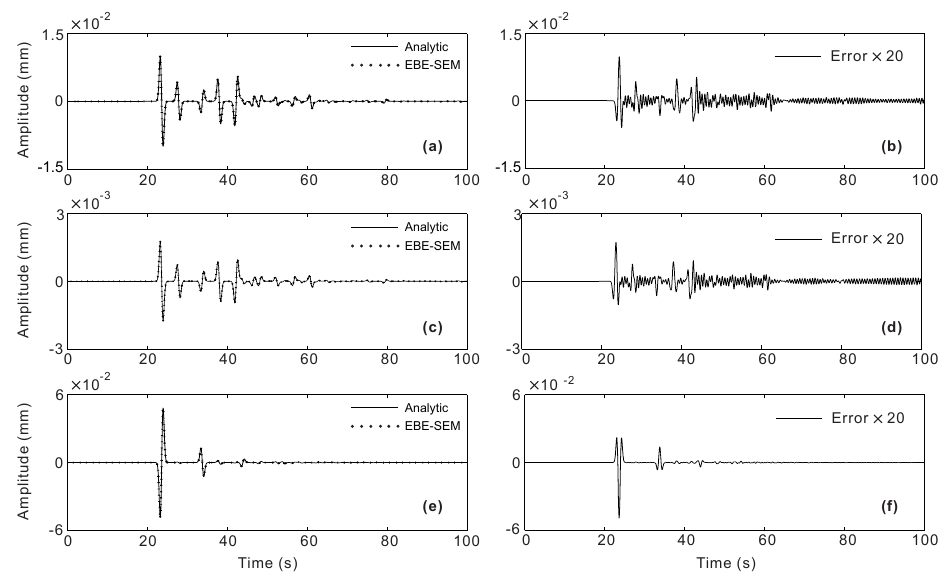
Figure 4. Comparison of the waveforms generated by EBE-SEM (dotted line) and FK (solid line). The waveform computed by FK is considered the reference solution. Panels (a) , (c) , and (e) are the waveforms in the x , y , and z directions, respectively. The error curves presented in the right panels are obtained by subtracting of the numerical solution from the reference solution. For visualization purposes, the errors are multiplied by